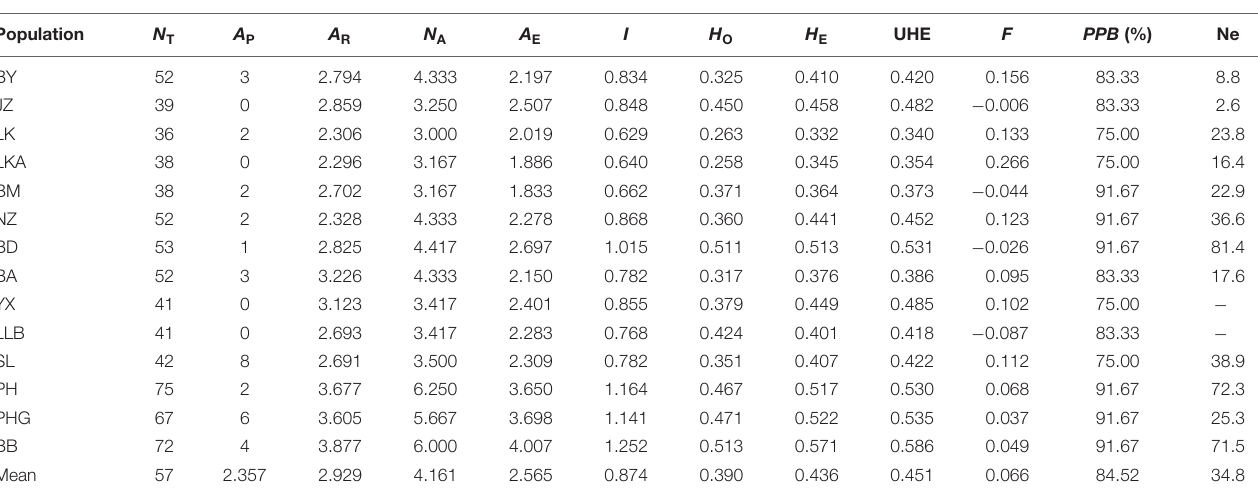
FIGURE 4 | Bayesian skyline plots based on cpDNA (A) and the nuclear genes GTP (B) , PHYP (C) , and PPRC (D) for the estimate of fluctuations in effective population size over time. Black line: median estimation; area between gray lines: 95% confidence interval. MIS, Marine Isotope Stage. TABLE 2 | Genetic diversity within populations of C. segmentifida